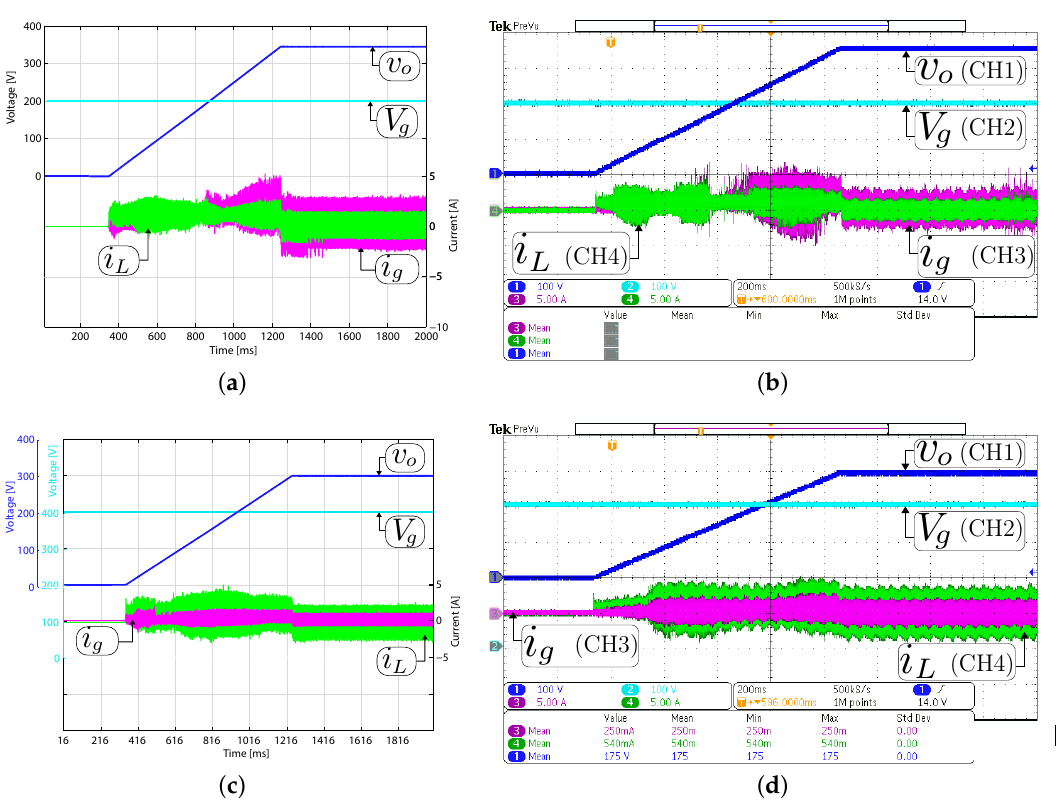
Figure 13. System startup with an EV powertrain system emulation. Simulated ( a , c ) and experimental ( b , d ). Two operation modes in steady-state are shown: ( a , b ) boost mode ( V g = 200 V, v o = 350 V) and ( c , d ) buck mode ( V g = 400 V, v o = 300 V). CH1: v o (100 V/div), CH2: V g (100 V/div), CH3: i g (5 A/div), CH4: i L (5 A/div), and time base of